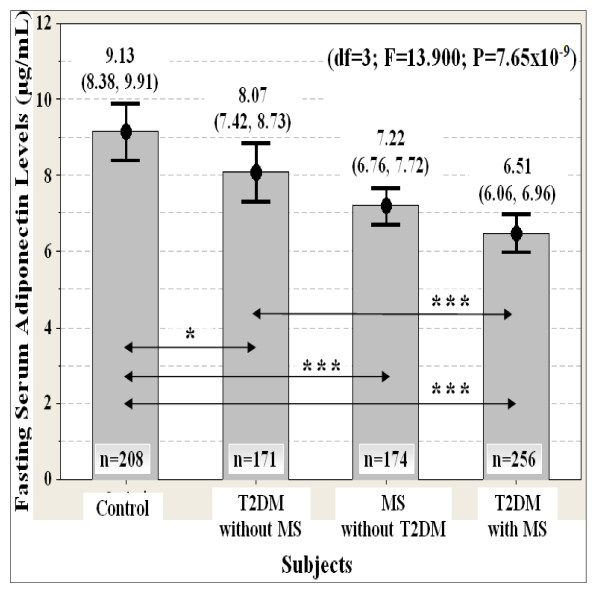
Association of fasting serum adiponectin levels with T2DM and MS susceptibility (n = 809). Data are expressed as mean (95% confident interval). ANCOVA test was used, followed by pairwise comparison using 1,000 stratified bootstrap samples with bias corrected and accelerated (BCa) 95% CI for multiple testing bias corrections due to deviation of normality. The p-value was also adjusted for covariate ages with stratified ethnicity. The location of statistically significant differences are displayed as the double arrow. Significant levels: P* < 0.05, P** < 0.01, P*** < 0.001. Note: T2DM = type 2 diabetes; MS = metabolic syndrome.